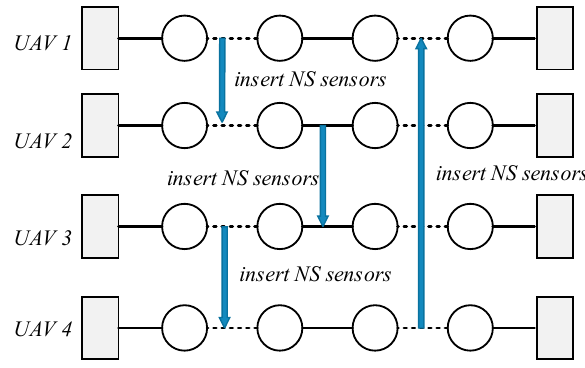
Figure 2. An example of a sensor cyclic exchange operator. Table 1. The shaking neighborhood structures.